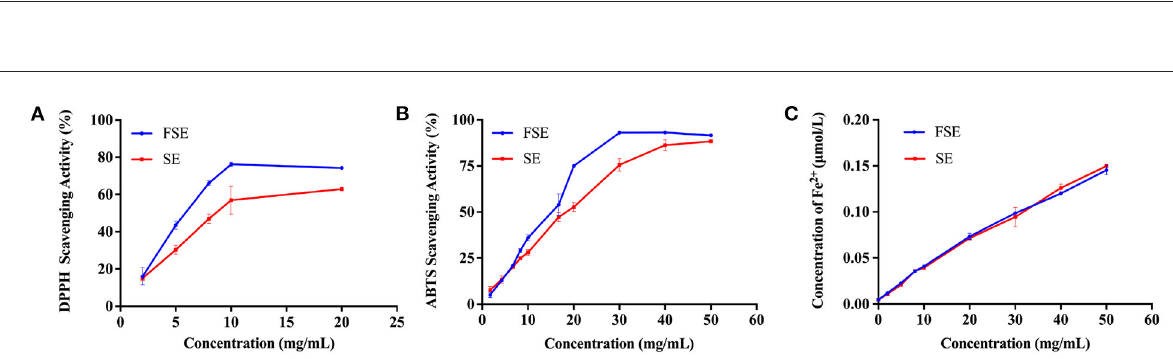
Cell viability, ROS release, and malondialdehyde (MDA) and superoxide dismutase (SOD) activity were measured. The cytotoxic effect of FSE and SE was tested as shown in Figure 5B. The cell viability of the control group was